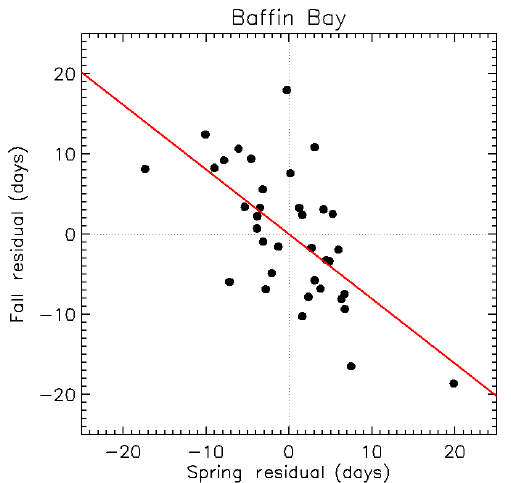
Figure 9. Date of fall sea-ice advance (de-trended) vs. date of spring sea-ice retreat (de-trended) for Baffin Bay (all depths). The de- trended dates have correlation − 0.64. This suggests that the date of fall sea-ice advance can be predicted from the date of spring sea- ice retreat with more skill than simply extrapolating the fall trend. See Table 3 for correlations in all regions. The red line is the least- squares fit.